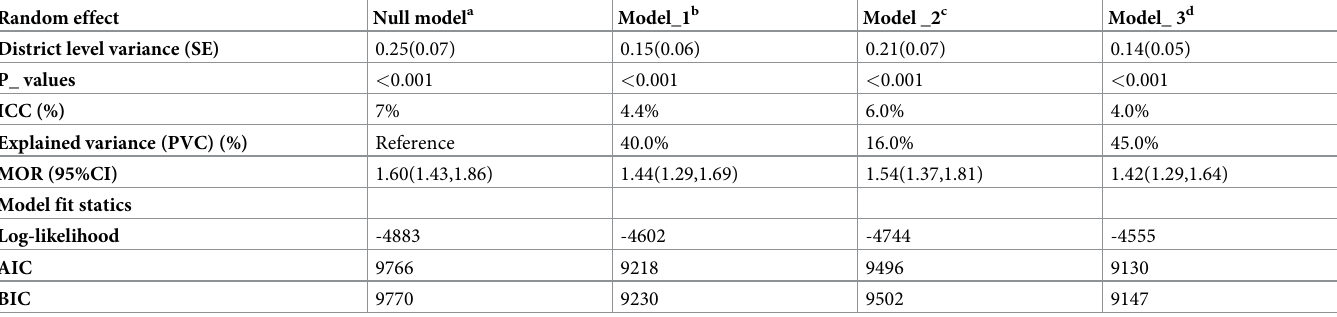
Table 5. The random effect model in examining the factors linked to delays relate to maternal death in